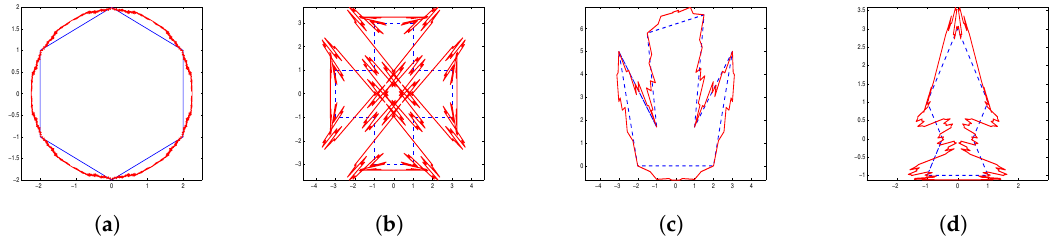
Figure 2. Example of the subdivision schemes with fractal behavior. ( a ) Behavior of the schemes for α = 0.00813; ( b ) Behavior of the schemes for α = 0.00818; ( c ) Behavior of the schemes for α = 0.0078; ( d ) Behavior of the schemes for α =